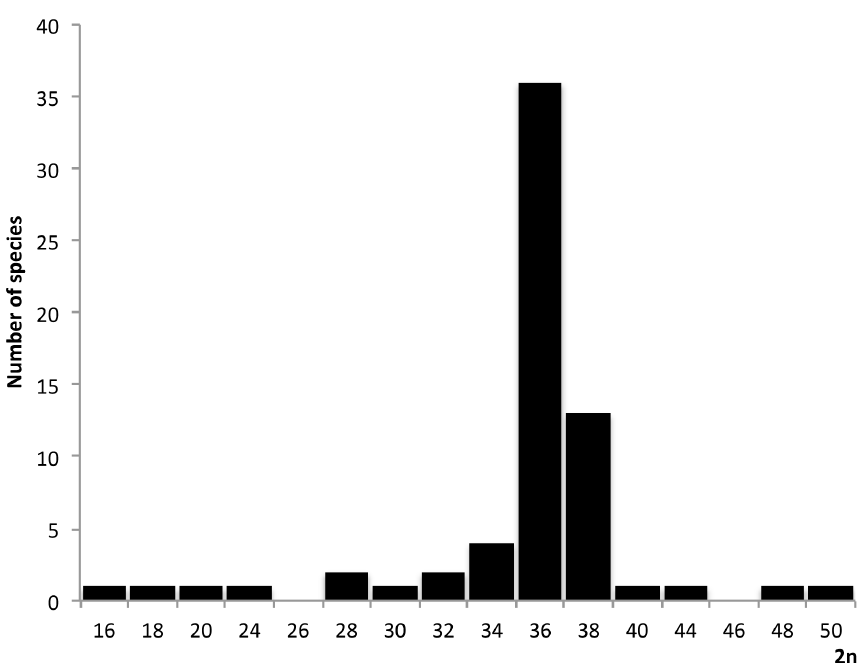
Figure 2. Histogram of the distribution of the diploid chromosome number (2n) in the genus Notho- branchius.